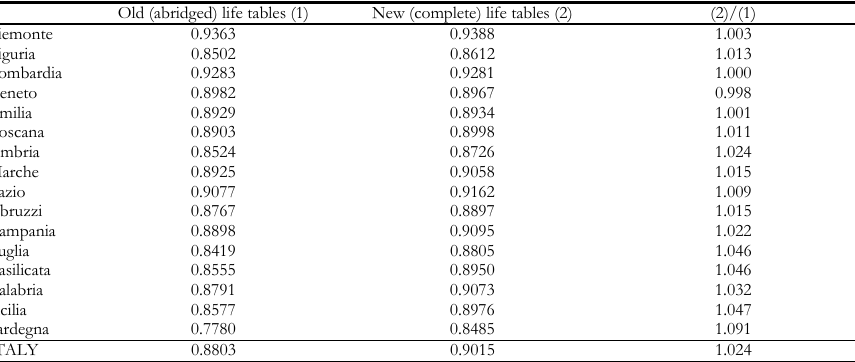
Regional values of 10 q 80 (both sexes) in 1881-82: comparison between old life tables and new ones (splines) Old (abridged) life tables